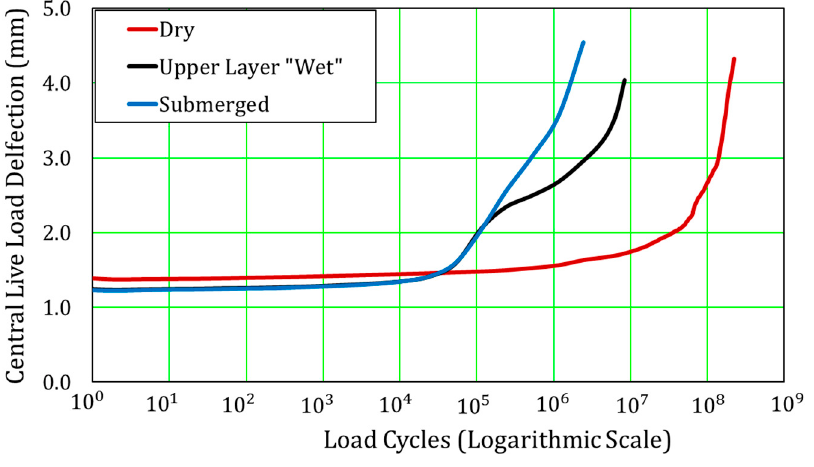
Table 2. Remaining fatigue life of dry and wet ambient conditions.